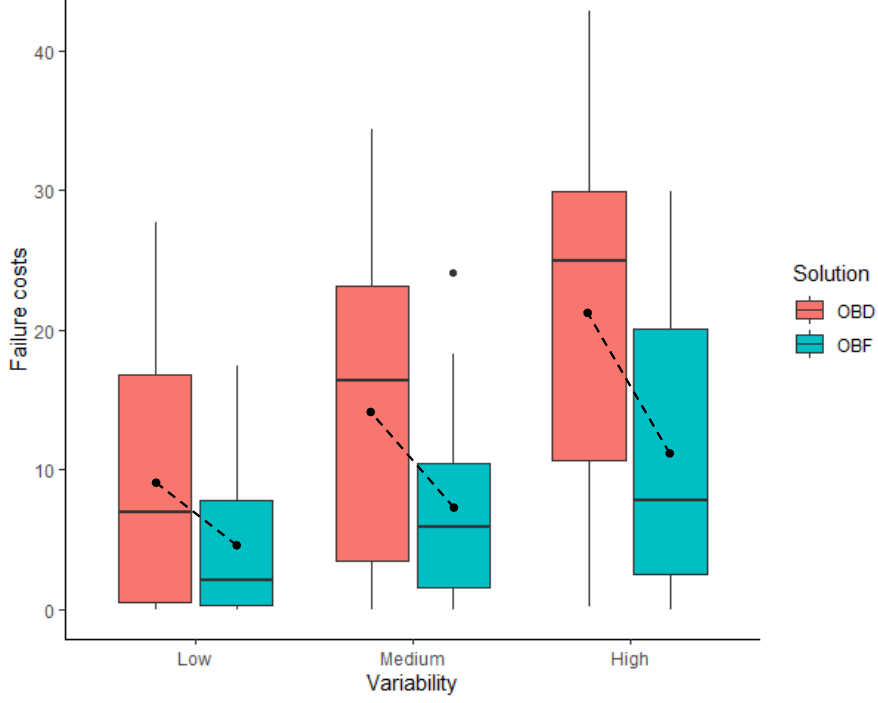
Figure 6. Failure costs of our best deterministic and our best hybrid